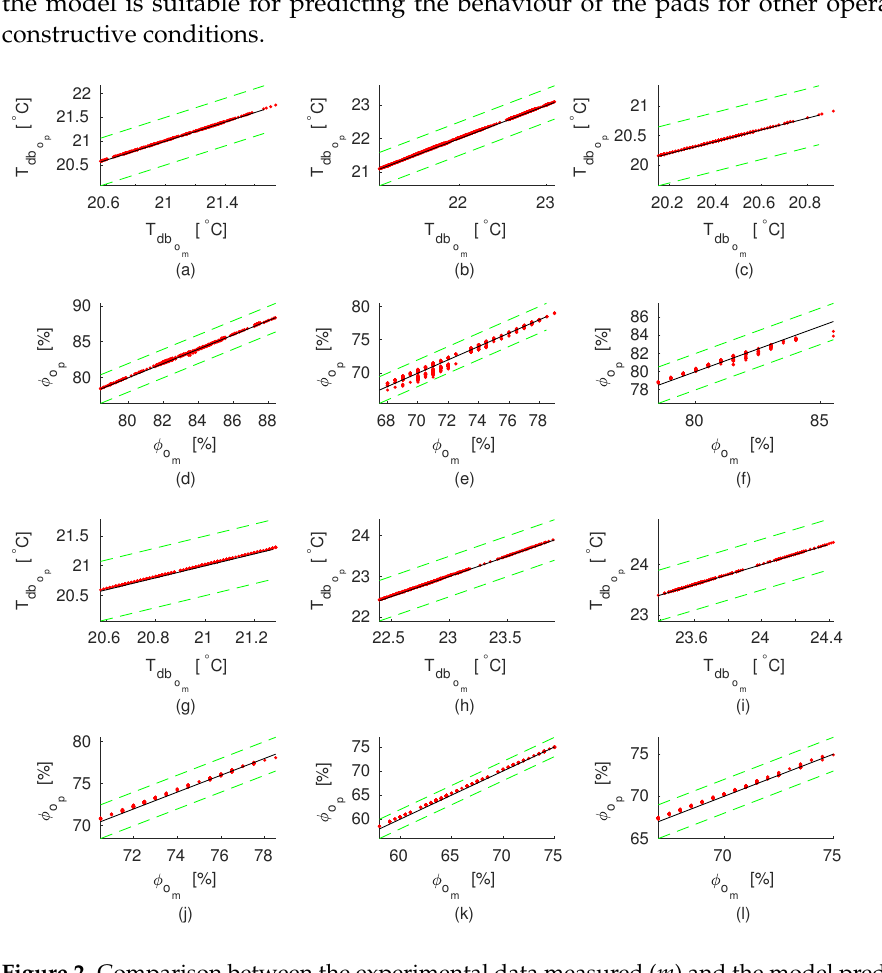
Figure 2. Comparison between the experimental data measured ( m ) and the model predictions ( p ) of the dry-bulb temperature ( T db ) and relative humidity ( φ o ) of outlet air for all the pads analysed. o ( a ) T db of CL pad. ( b ) T db of CS 1 pad. ( c ) T db of CS 2 pad. ( d ) φ o of CL pad. ( e ) φ o of CS 1 pad. ( f ) φ o o o o of CS 2 pad. ( g ) T db of BC pad. ( h ) T db of PS 1 pad. ( i ) T db of PS 2 pad. ( j ) φ o of BC pad. ( k ) φ o of PS 1 o o o pad. ( l ) φ o of PS 2 pad. Solid black line corresponds to the equality line. Dashed lines represent the interval of ± 0.5 ◦ C and ± 2% around the equality line of T db and φ o , o